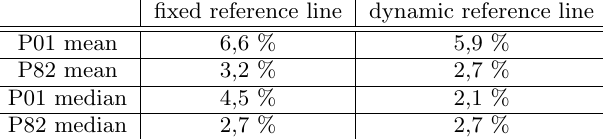
Table 1: Compare of fixed and dynamic reference line with the deviation in percent from the reference value.